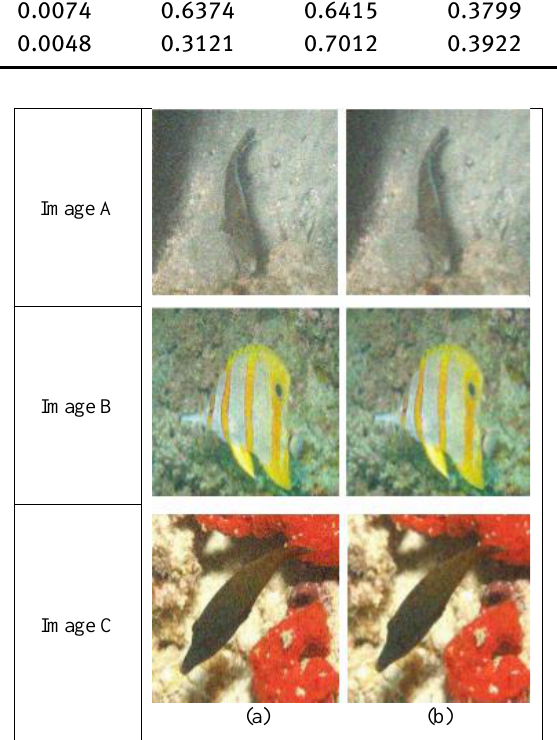
Figure 8: (a) Images with 0.1 Level Gaussian noise, (b) Denoised